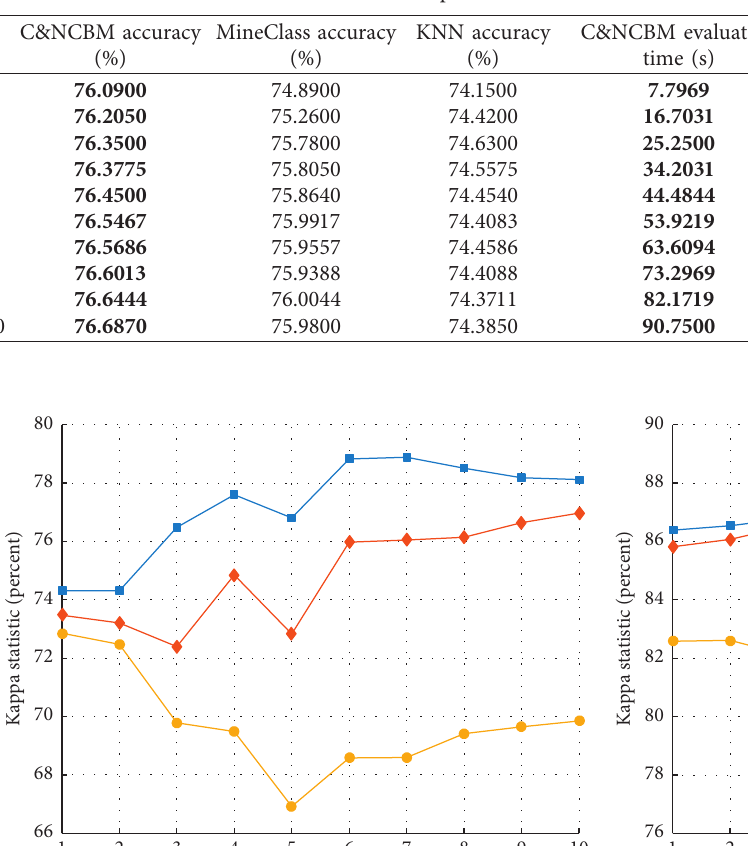
Table 6: Experimental result data in ArtificialCDS